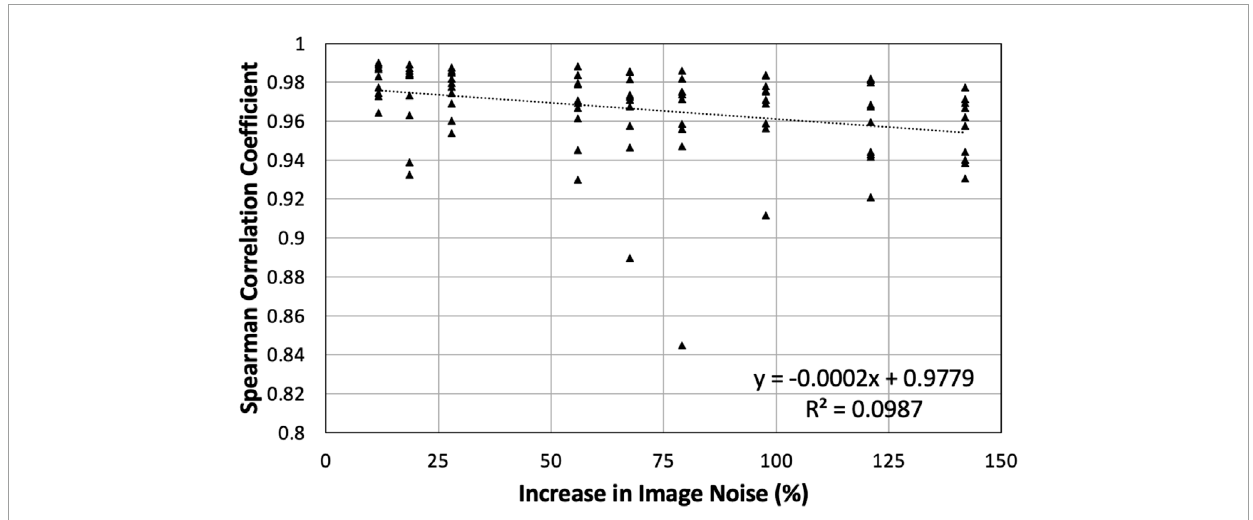
FIGURE 9 All Spearman correlation coefficients between full and reduced dose BHCT biomarkers without IR are plotted. Points are plotted based on the percentage increase in image noise of the reduced dose scan. Compared to 59 mAs, reduced dose scans of 10–47 mAs had increases in image noise of 12%–142 %